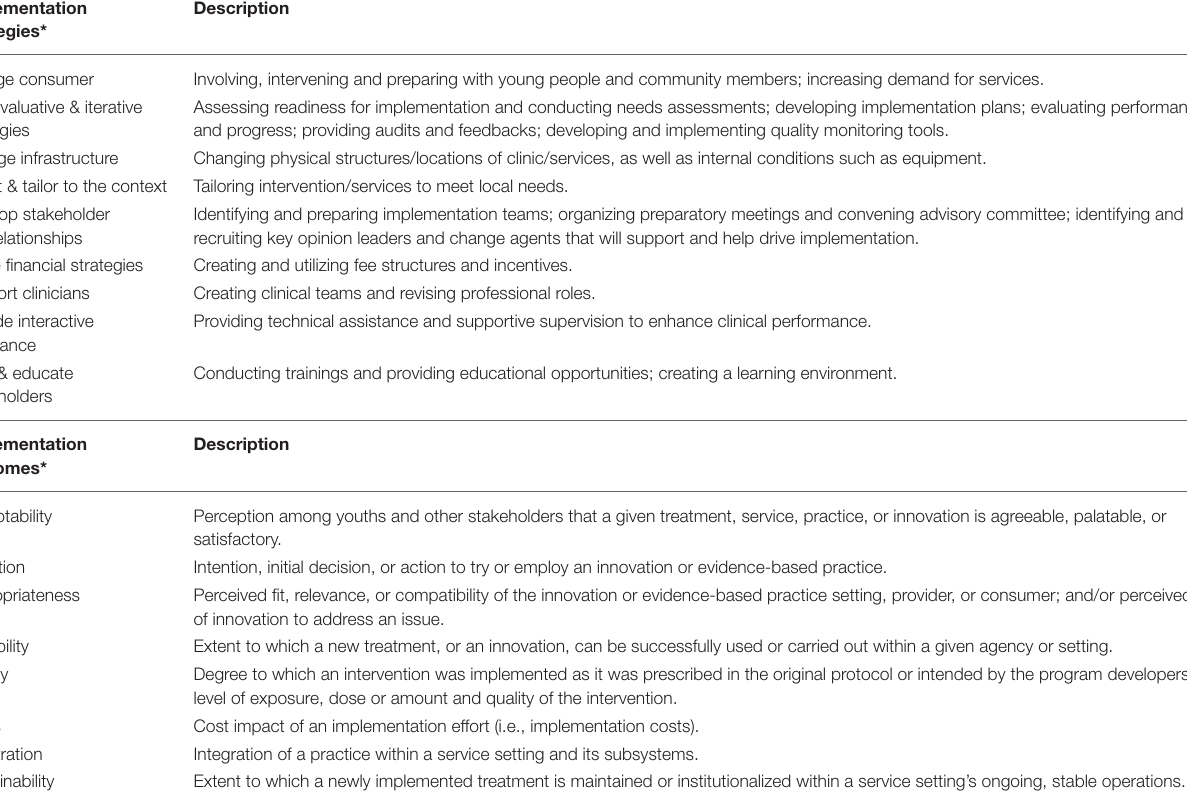
TABLE 1 | Implementation Strategies and implementation